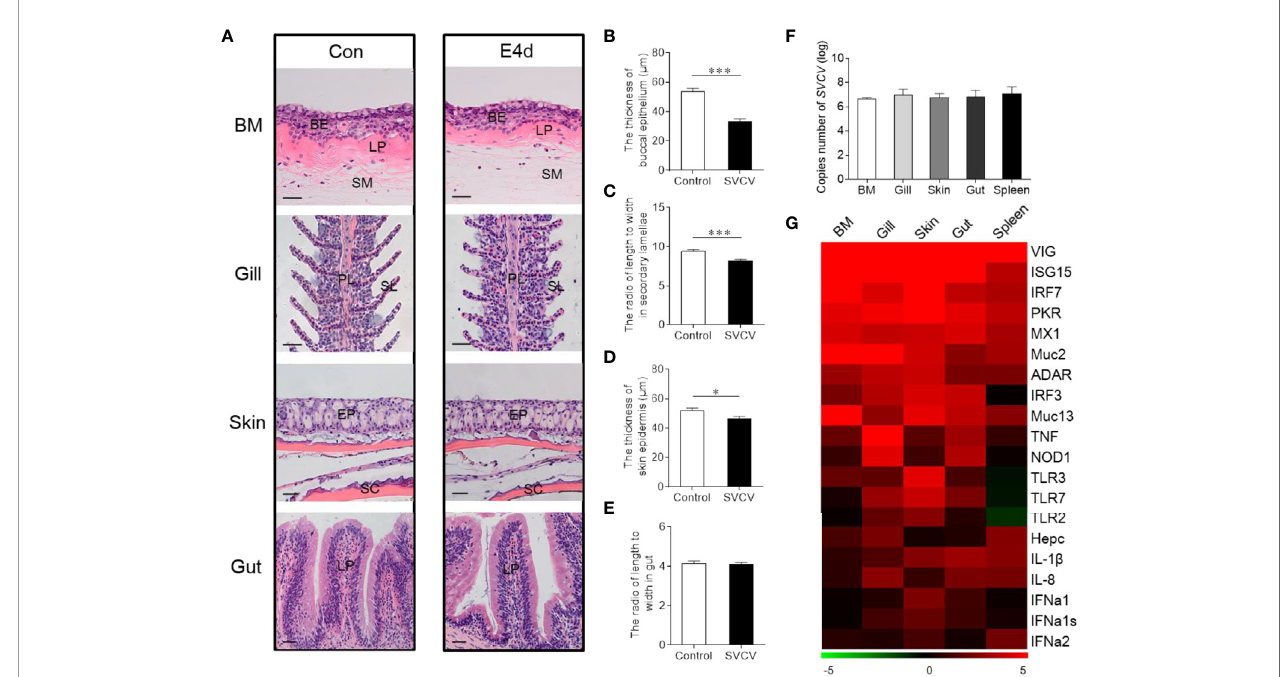
FIGURE 2 | Pathological changes and immune response in mucosal tissues of common carp following SVCV infection. (A) Histological examination of the mucosal tissues (including BM, gills, skin, and gut) from control fi sh and experimental fi sh infected with SVCV after 4 days ( n = 6 fi sh per group). (B) The thickness of BM epidermis in control and infected fi sh ( n = 6 fi sh per group). (C) The length-width ratio of secondary lamellae in control and infected fi sh ( n = 6 fi sh per group). (D) The thickness of skin epidermis in control and infected fi sh ( n = 6 fi sh per group). (E) The length-width ratio of gut villus in control and infected fi sh ( n = 6 fi sh per group). (F) The loads of SVCV in different tissues (BM, gills, skin, gut, and spleen) at 4 days after infection ( n = 9 fi sh per group). Data are representative of three independent experiments (mean ± SEM). (G) Heat map illustrates results from quantitative real-time PCR of mRNAs for immune-related genes in virus-challenged fi sh vs. control group measured at 4 days following with SVCV in the BM, gills, skin, gut, and spleen of common carp ( n = 6 fi sh per group). Color value: log2 (fold change). BM, buccal mucosa; BE, buccal epithelium; SM, submucosa; PL, primary lamellae; SL, secondary lamellae; EP, epidermis; SC, scales; LP, lamina propria; Scale bars, 20 µm. Control vs. Infected: * P < 0.05, *** P < 0.001, unpaired Student ’ s t -test. Data are representative of three different independent experiments (mean ±